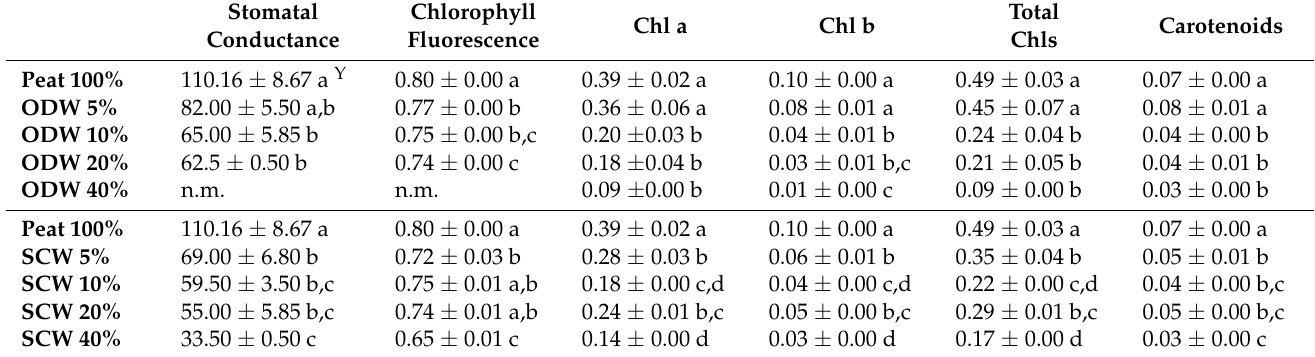
Table 4. Impact of growing media (peat, Origanum dubium waste—ODW, Sideritis cypria waste—SCW) on purslane chlorophyll fluorescence (Fv/Fm), stomatal conductance (s/cm), chlorophylls (Chl a, Chl b, total Chls; mg/g fw), and carotenoid (mg/g fw)